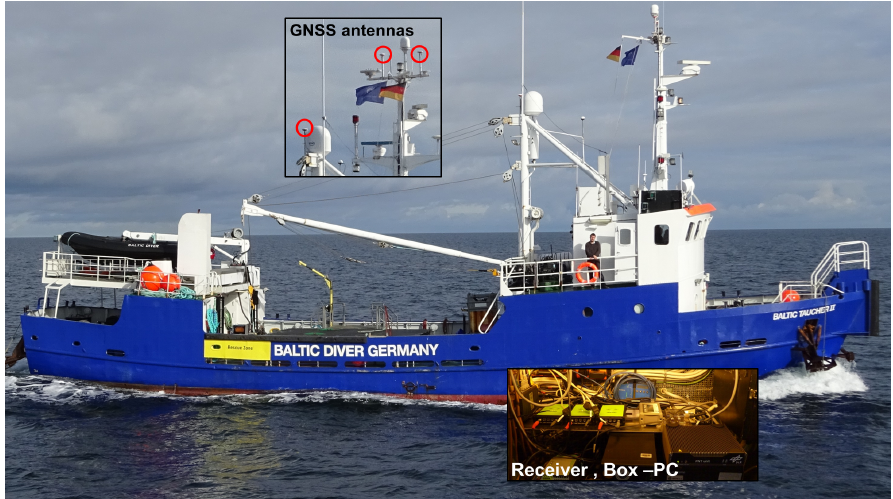
Figure 4. BALTIC TAUCHER II with the mounting of the